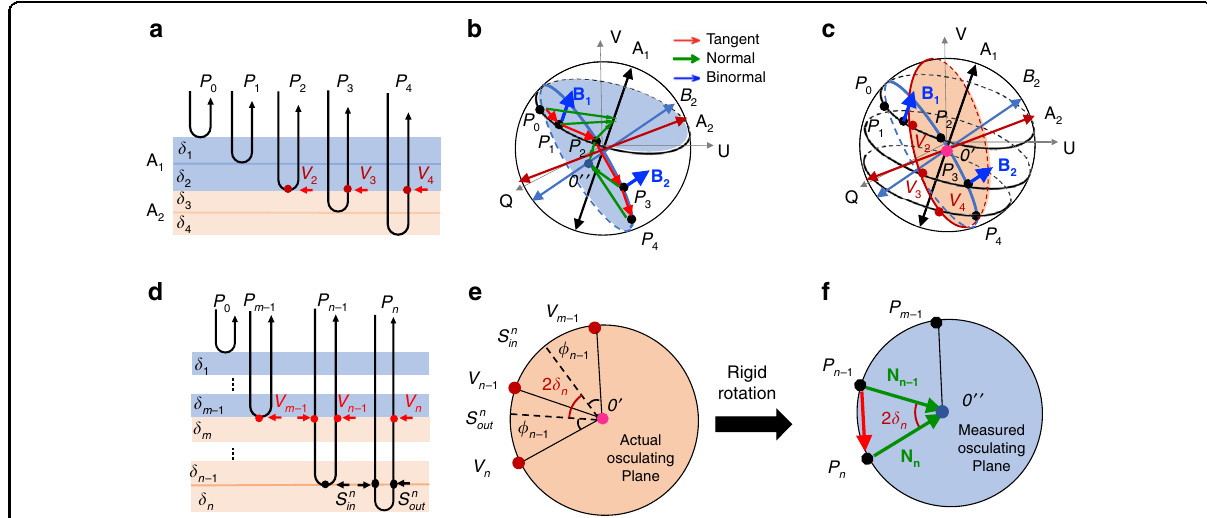
Fig. 5 Schematic diagram of the PSOCT-based polarization state transmission model. Shown is the model in a simulated birefringent sample with depth-varying optic axis, representing a A-scan in the imaging. P 0 , P 1 , P 2 , P 3 and P 4 , are the output polarization states that are detected by the PSOCT system. a A depth scan of a simulated birefringent sample with depth-varying optics axis, where 4 birefringent layers are simulated with the fi rst 2 layers sharing the same optic axis A 1 , and the last two layers sharing A 2 . V 2 , V 3 and V 4 are the intermediate polarization state that are only in fl uenced by the local birefringence. b The trajectory curve of the output polarization states P 0 , P 1 , P 2 , P 3 and P 4 on the Poincare ́ sphere with the corresponding TNB vectors. The measured osculating planes spanned by the T and N vectors are colored by blue. c The geometric relation between the upper optic axes, A 1 ð i : e :; B 1 Þ , the axis of the measured osculating plane B 2 and the local optic axis A 2 . The actual osculating plane is colored by red. d A depth scan of a simulated birefringent sample with depth-varying optic axis. e The actual osculating plane composed by the V m (cid:2) 1 to V n . f The measured osculating plane composed by P m (cid:2) 1 to P n . O ’ (pink points) and O ” (blue points) are the center of the actual and measured osculating planes, respectively. Red, green and blue arrows represent the tangent (T), normal (N) and binormal (B) vectors,